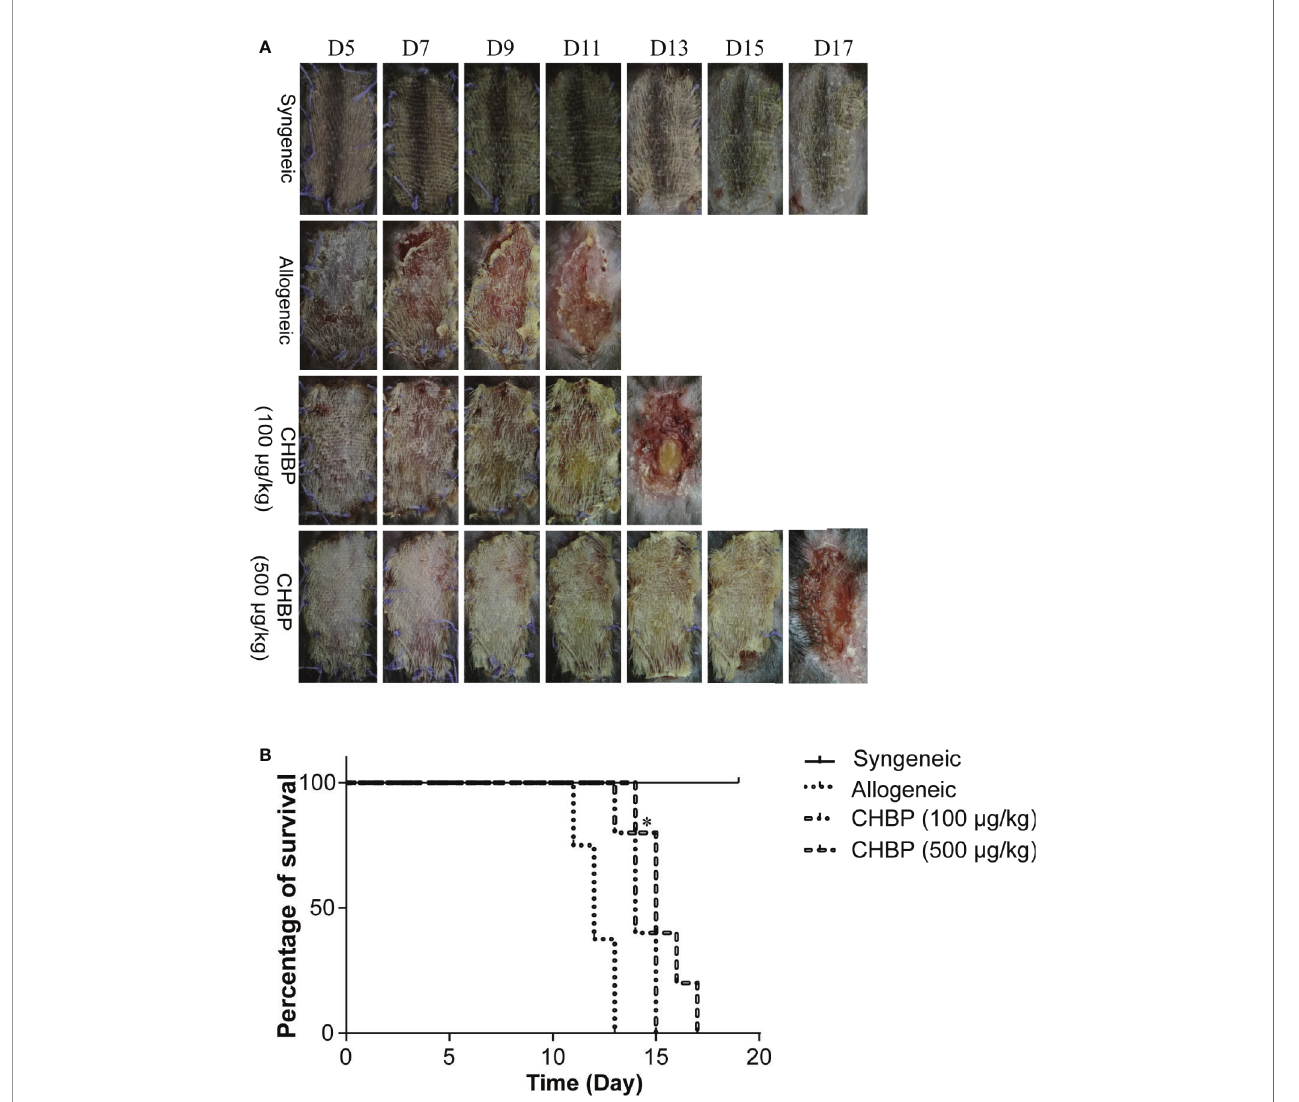
FIGURE 1 | CHBP prolonged skin allograft survival. (A) Photographs of skin allografts at various time points after secondary transplantation in each group. (B) Kaplan – Meier survival curves of mice in each group by day of post-transplantation. *P < 0.05: This P value is compared between the allogeneic group and the CHBP (500 µg/kg)